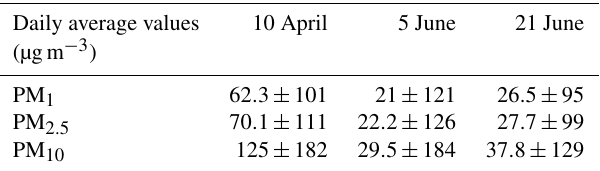
Table 1. Daily average PM 10 , PM 2 . 5 , and PM 1 values measured by the DustTrak during each